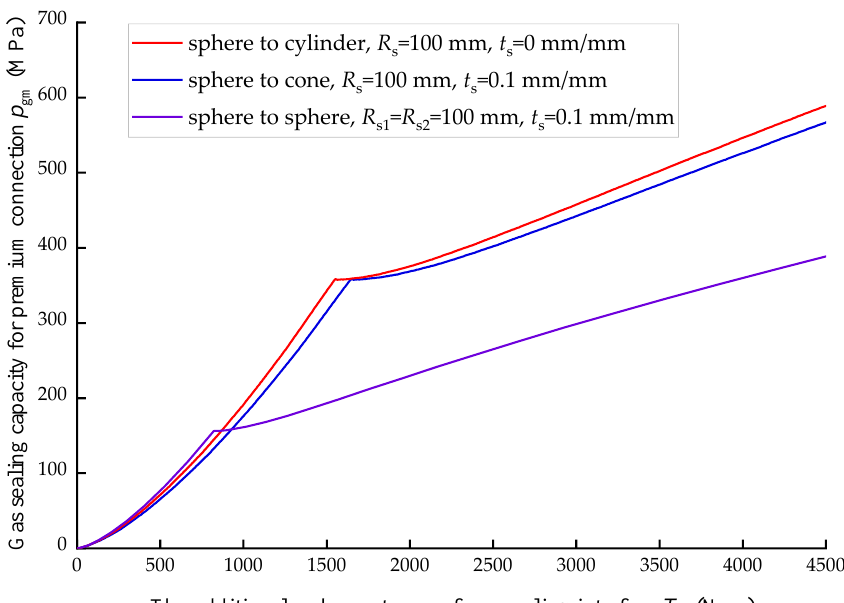
Figure 11. Effects of additional make-up torque from sealing interface on gas sealing capacity for three kinds of sphere-type premium connections.